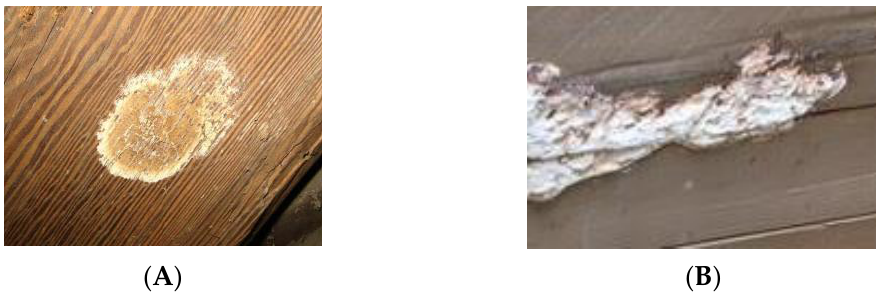
Figure 20. Mold growing on the wood surface ( A ) and mildew on a wood surface ( B ).